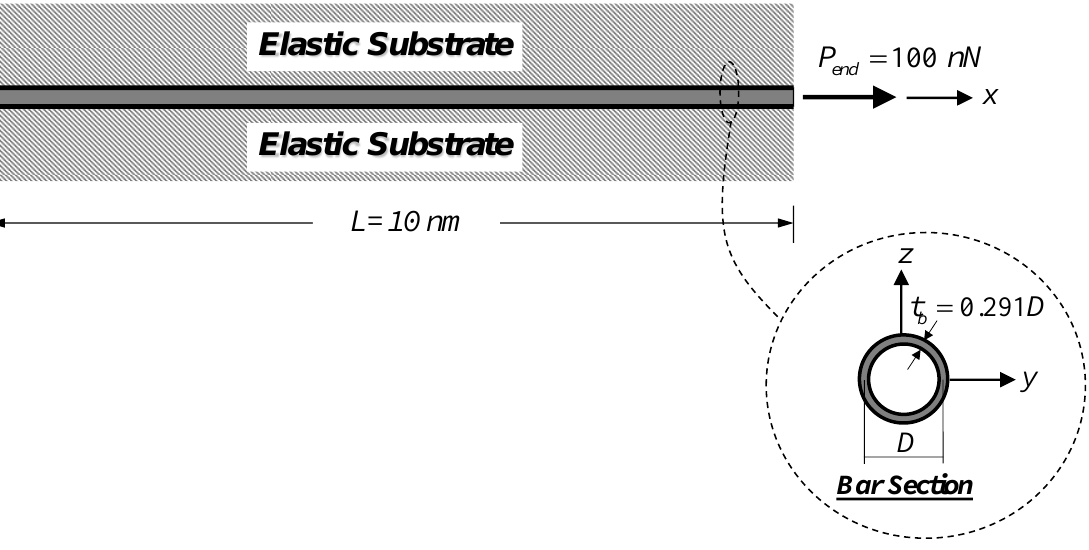
Figure 6. Free – free SWCNT – substrate medium system under an end force: static analysis. Figure 6. Free–free SWCNT–substrate medium system under an end force: static analysis. Classical and non-classical boundary conditions for the free–free SWCNT–substrate system follow those suggested by Akgöz and Civalek [59]: